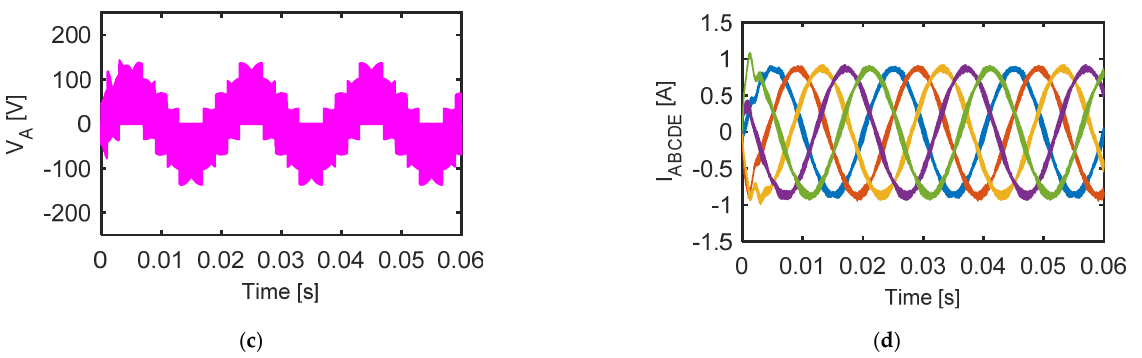
Figure 13. Simulation results at 50 Hz output frequency ( a ) voltage of the DC link, ( b ) output line voltage, ( c ) output phase voltage and ( d ) output phase currents.